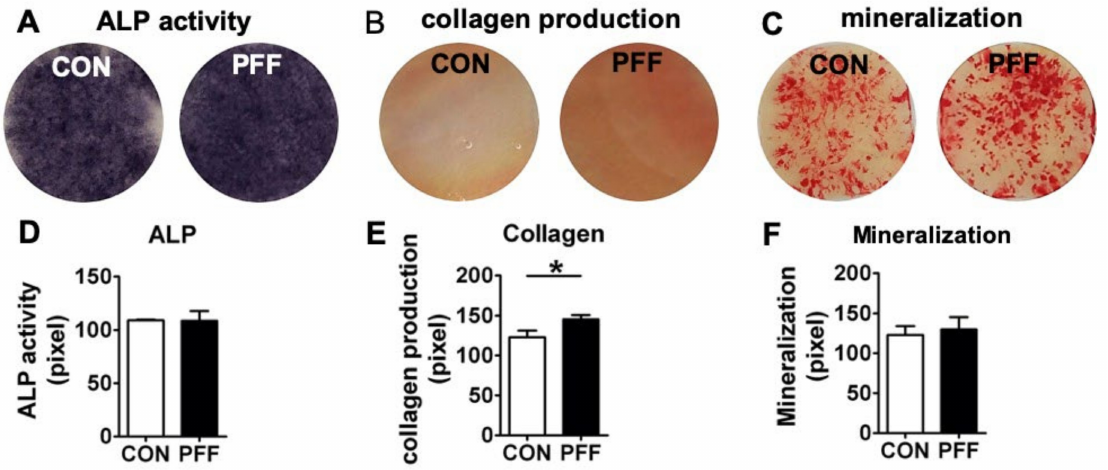
Figure A4. E ff ect of PFF on osteogenic di ff erentiation of MC3T3-E1 osteoblasts. Prior to 1 h PFF, the medium was refreshed by α -MEM containing 2% FBS and antibiotics. PFF (amplitude: 1.0 Pa, peak shear stress rate: 6.5 Pa / s, frequency: 1 Hz) was generated for 1h using a pump and a parallel-plate flow chamber. Static control cultures were kept in a petri-dish under similar conditions as experimental cultures. Cells were post-incubated for up to 28 days. ( A – C ) The optical images show alkaline phosphatase (ALP) activity, collagen production, and mineralization after 21 or 28 days of cell culture. ( D – F ) Quantification of ALP activity, collagen production, and mineralization after 21 or 28 days of cell culture. CON, control; PFF, pulsating fluid flow. * p <